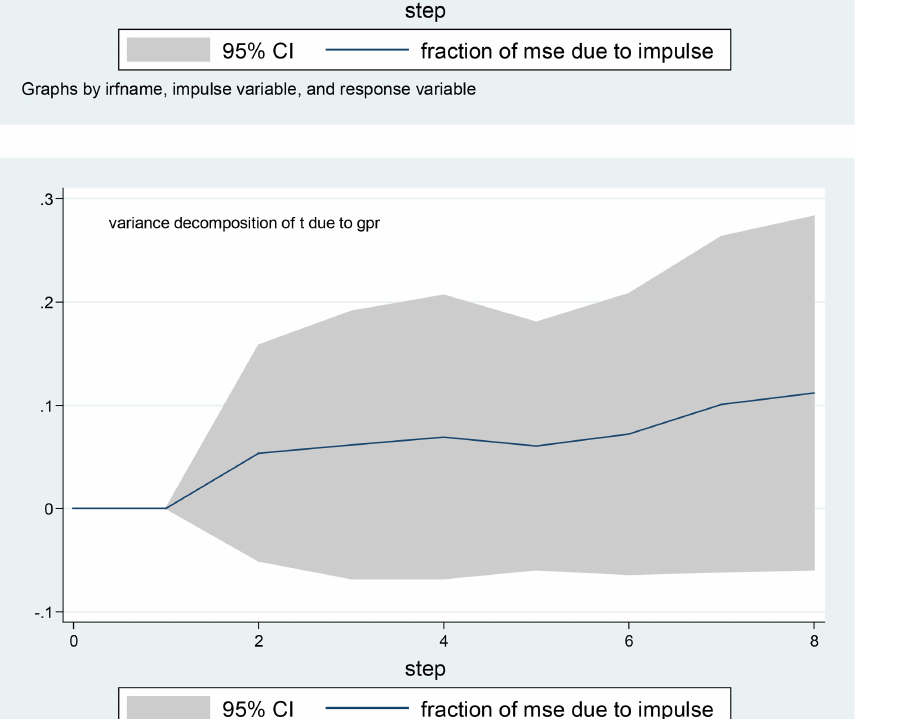
Figure 4. Variance decomposition of